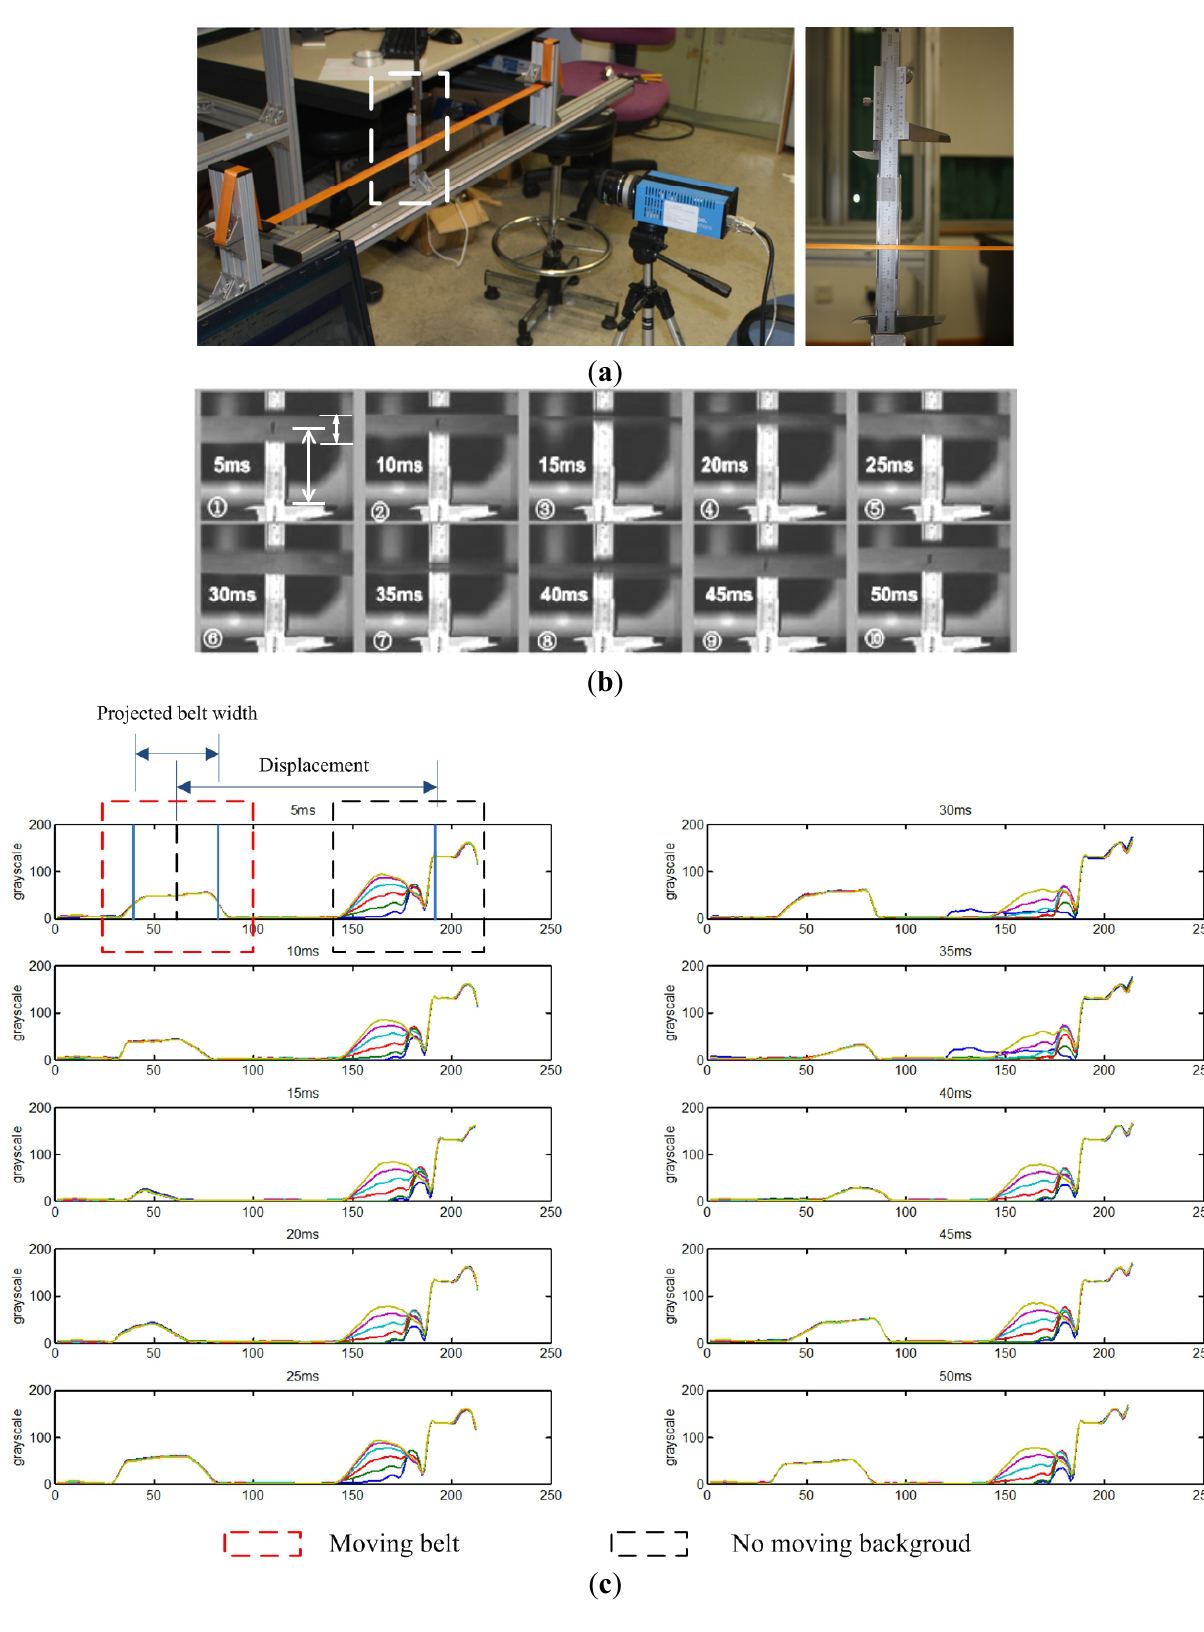
Figure 4. ( a ) High speed camera based displacement measure system; ( b ) Flutter image series captured by high speed camera (PCO 1200S); ( c ) Image sequences processing using grayscale edge